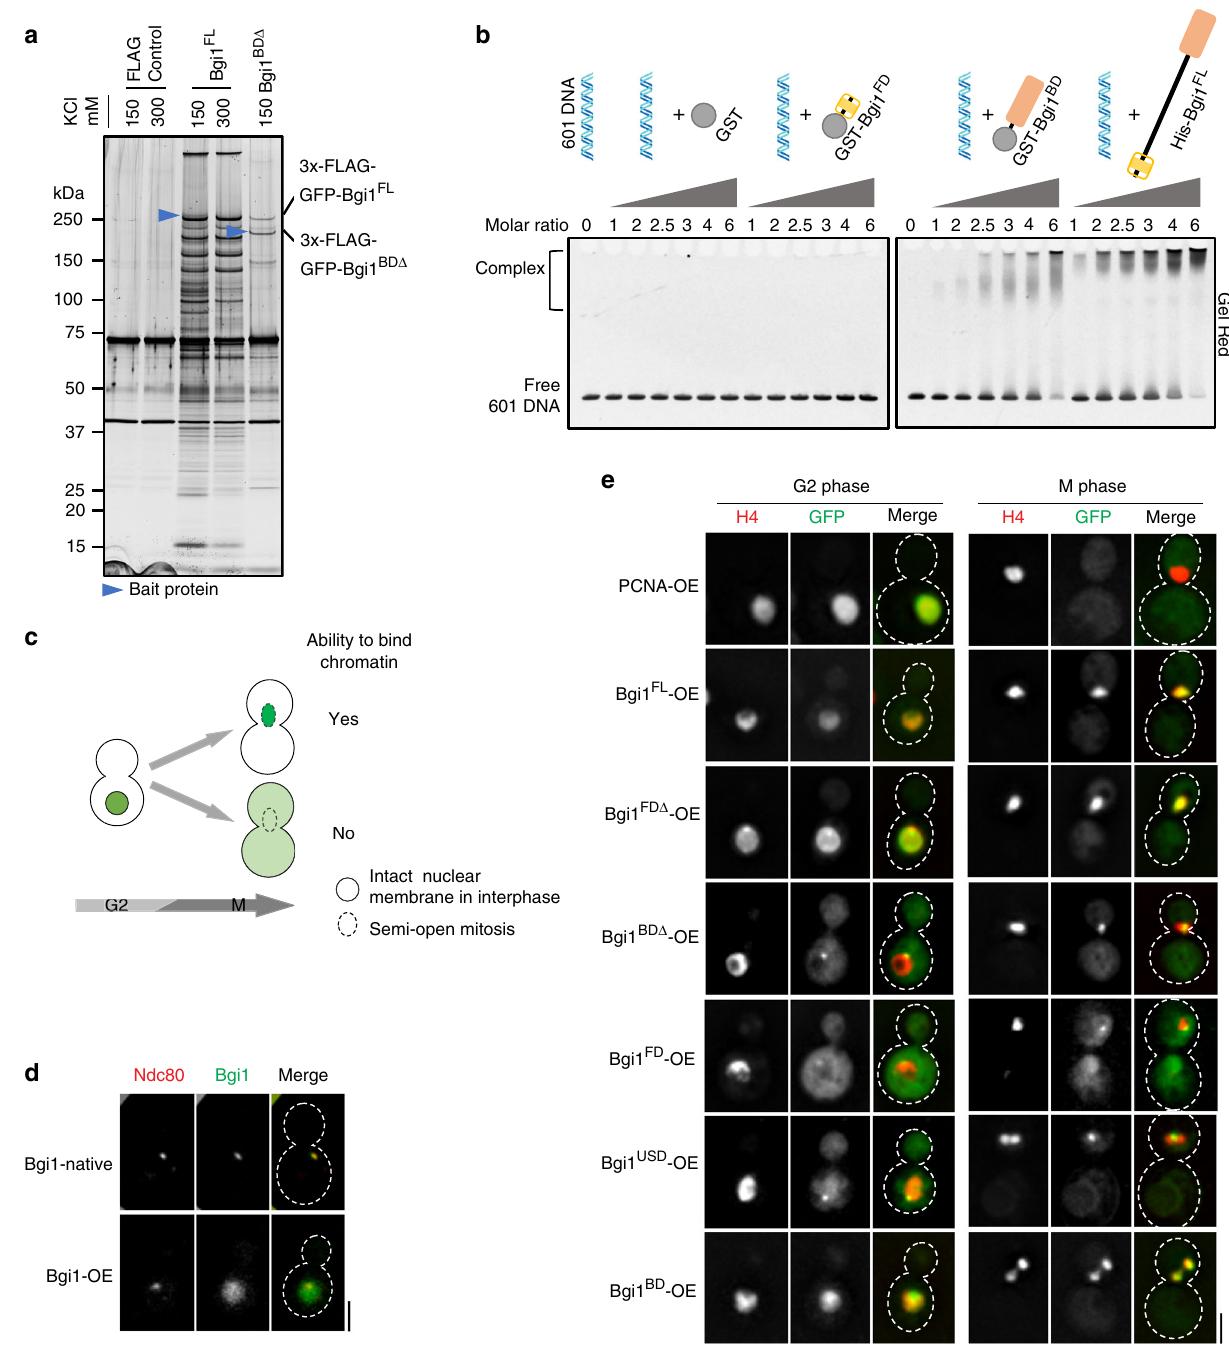
Fig. 6 The basic domain of bridgin has a property to interact with DNA nonspeci fi cally in vitro and in vivo. a Proteins eluted from TBZ-treated cells after FLAG-IP of Bgi1 FL expressing SHR879, Bgi1 BD Δ expressing SHR880, and a FLAG control strain SHR942 expressing Bgi1 were separated on a gradient PAGE gel and silver-stained. Blue arrows mark the bait proteins. b Electrophoretic mobility shift assay (EMSA) samples were separated on a PAGE gel and stained with GelRed for visualization. c Chromatin-bound proteins (green) colocalize with the nuclear marker histone H4-mCherry in metaphase, while free nuclear proteins diffuse into the cytoplasm following the entry into mitosis. d Visualization of GFP-Bgi1 when expressed under the native (SHR847, BGI1:: BGI1-V5-GFP ) or an overexpression (OE) GAL7 promoter (SHR858, BGI1::GAL7p-GFP-BGI1 ). Outer kinetochore protein Ndc80-mCherry was used to mark the kinetochore. e Visualization of bridgin OE constructs. The expression of OE constructs of Bgi1 FL (SHR895, SHR832::H3p-GFP-BGI1 FL ), Bgi1 FD Δ (SHR920, SHR832::H3p-GFP-BGI1 FD Δ ), Bgi1 BD Δ (SHR921, SHR832::H3p-GFP-BGI1 BD Δ ), Bgi1 FD (SHR922, SHR832::H3p-GFP-BGI1 FD ), Bgi1 USD (SHR923, SHR832::H3p-GFP- Bgi1 USD ) and Bgi1 BD (SHR924, SHR832::3×FLAG-GFP-BGI1 BD ), and GFP-PCNA control (SHR854, BGI1, CNVY121::H3p-GFP-PCNA ) was visualized in G2 and M phases. Histone H4-mCherry was used to mark chromatin. Scale bar, 3 μ m. Source data are available as a Source Data fi